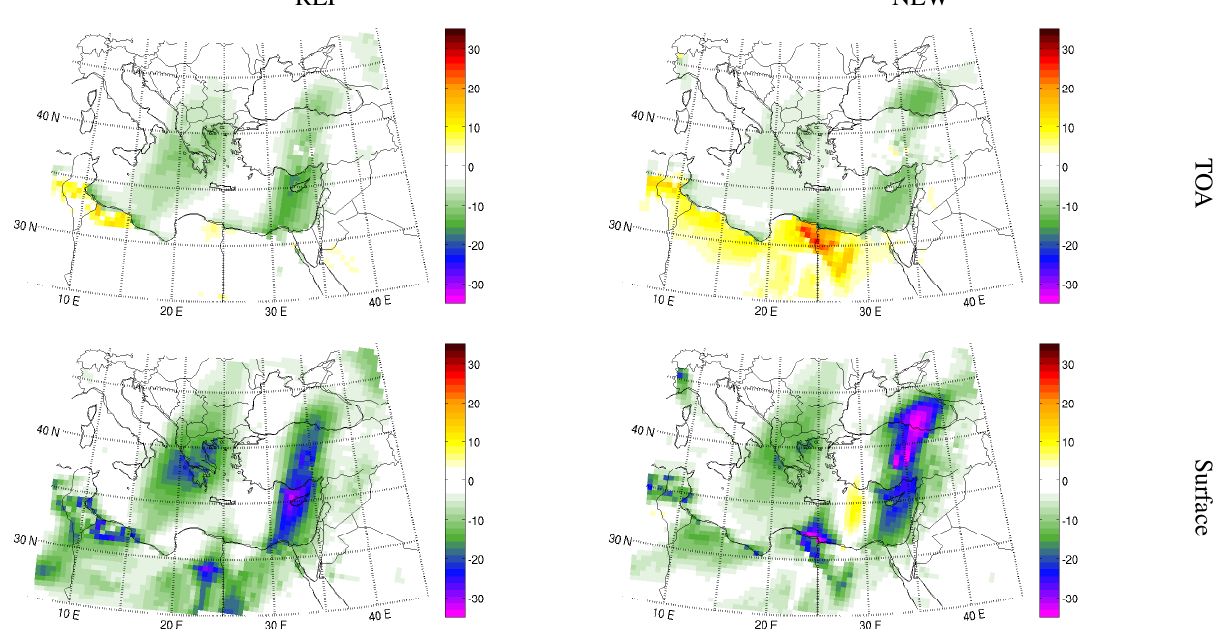
Fig. 5. Direct radiative forcing (in Wm − 2 , shortwave and longwave) simulated in REF (left panels) and NEW (right panels), at the surface (bottom panels) and at the top of the atmosphere (TOA, top panels) during the outbreak (23–25 March 2008).